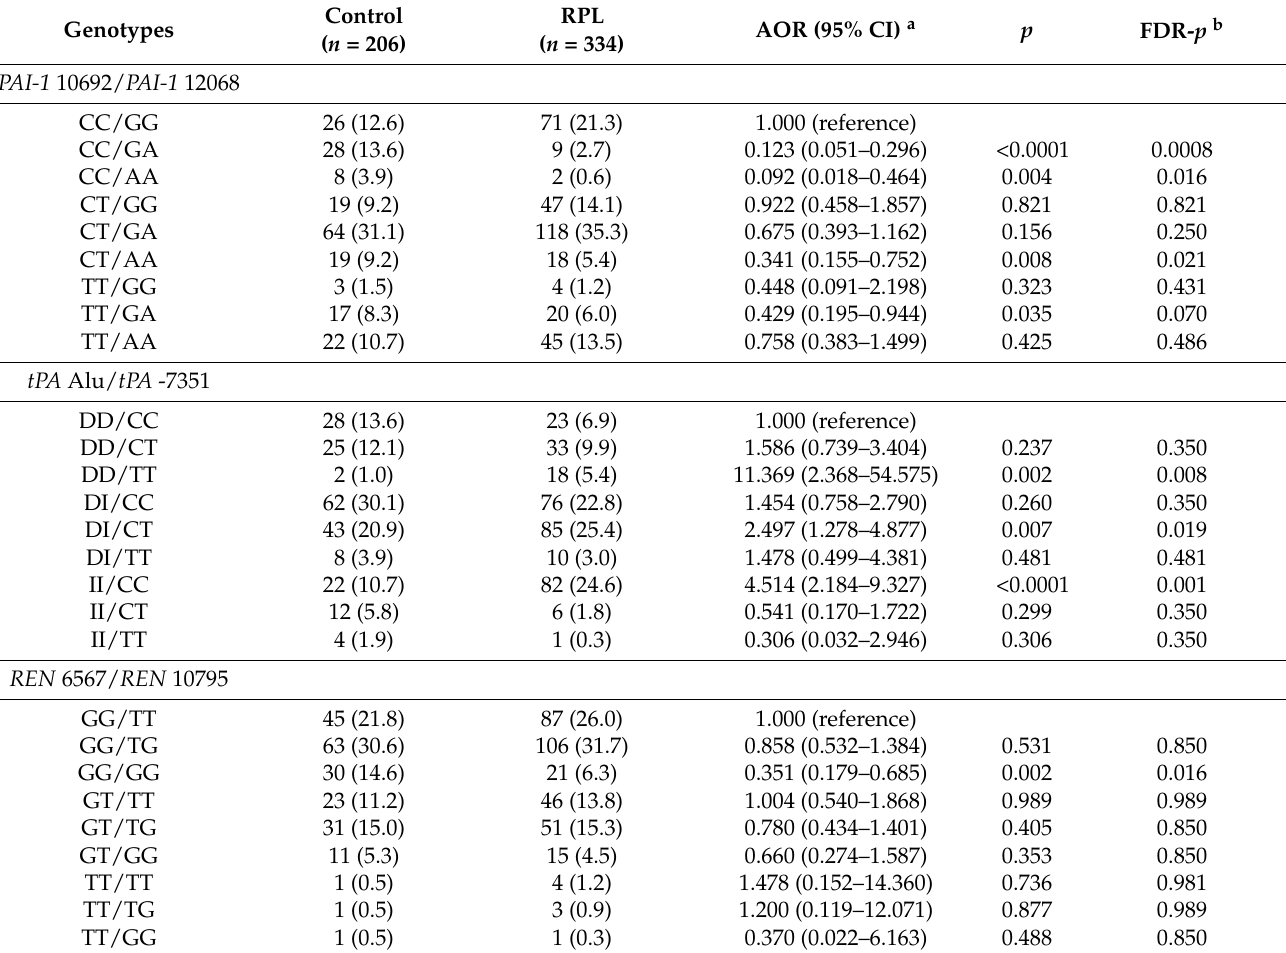
Table 3. Combination analysis of PAI-1 , t-PA and REN gene polymorphisms between RPL patients and